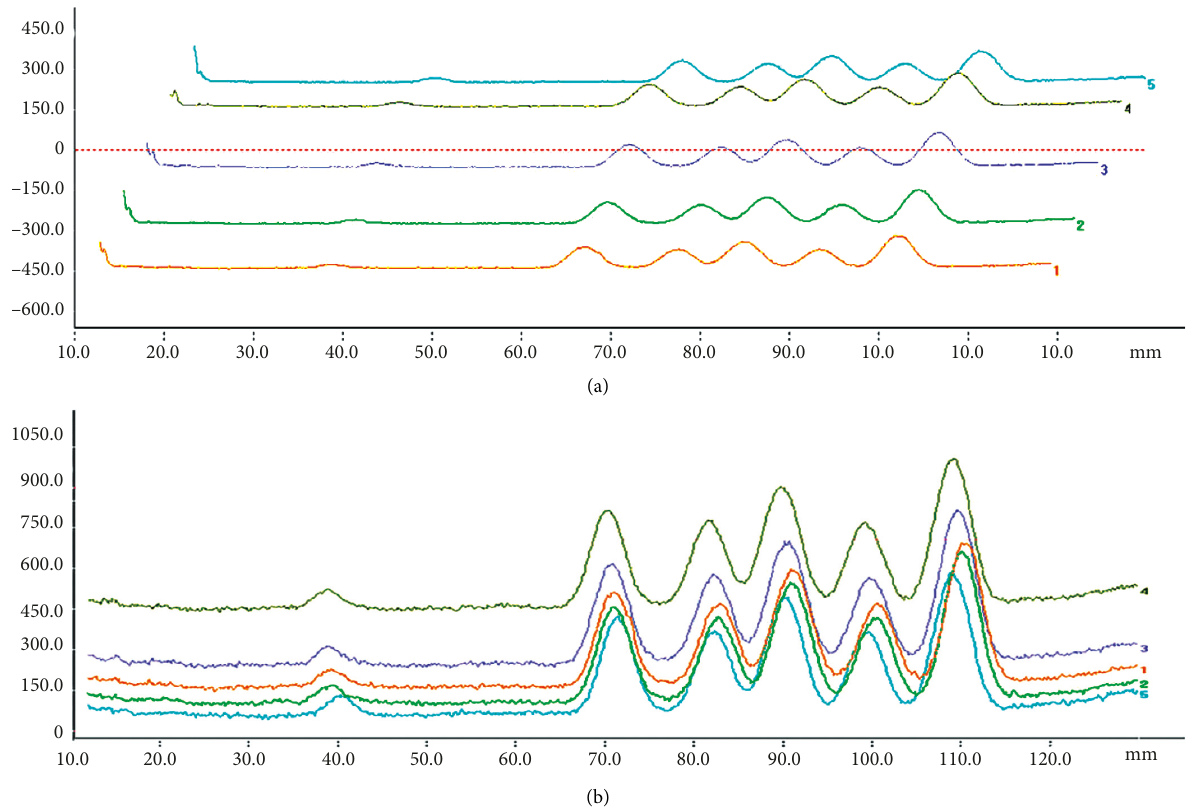
Figure 1: Chromatogram profile of standard and samples. Note . (a), (b) 1–5 are HPTLC scanning images of 2, 4, 6, 8, and 10 μ L sampling volume of the standard solution and sample solution. The chromatographic peaks from left to right were oxypeucedanin, imperatorin, osthole, columbianadin, and isoimperatorin.